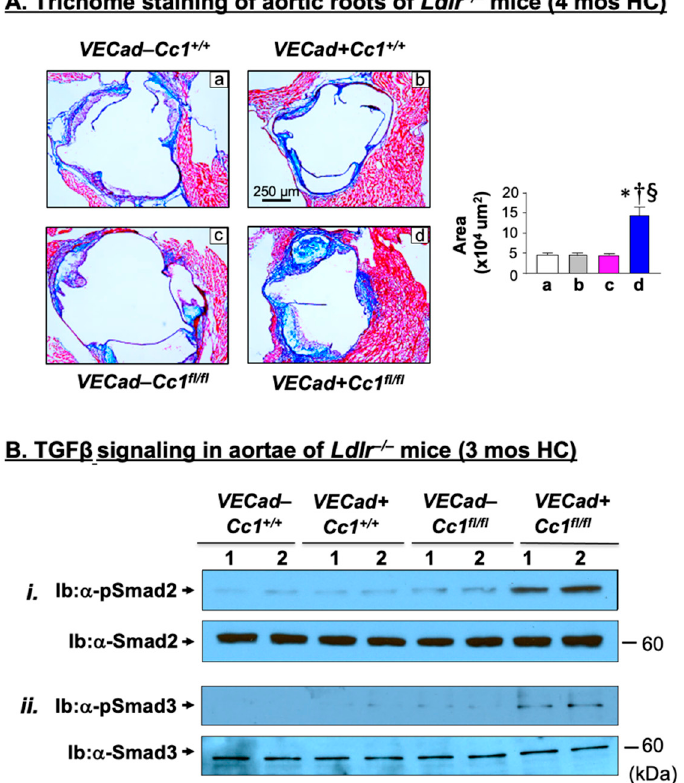
Figure 6. Vascular fibrosis. Male mice (n = 4/genotype) were fed HC for 4 months. ( A ) Aortic roots were stained with Gomori trichrome to detect collagen deposition. The total positively stained areas (blue) were calculated as area pixel 2 using Image J and are presented in the accompanying graph. * p < 0.05 vs. Ldlr − / − VECad–Cc1 +/+ (a, white bar); † p < 0.05 vs. Ldlr − / − VECad+Cc1 +/+ (b, grey bar) and § p < 0.05 vs. Ldlr − / − VECad–Cc1 fl/fl (c, teal bar). ( B ) Aortic lysates from mice fed HC for 3 months were analyzed by immunoblotting with (i) α -phospho-Smad2 ( α -pSmad2) and (ii) α -phospho-Smad3 ( α -pSmad3) antibodies and with antibodies against Smad2 and Smad3, respectively, in parallel gels for normalization. Gels represent analysis on 2 mice/genotype performed on different sets of mice/protein.